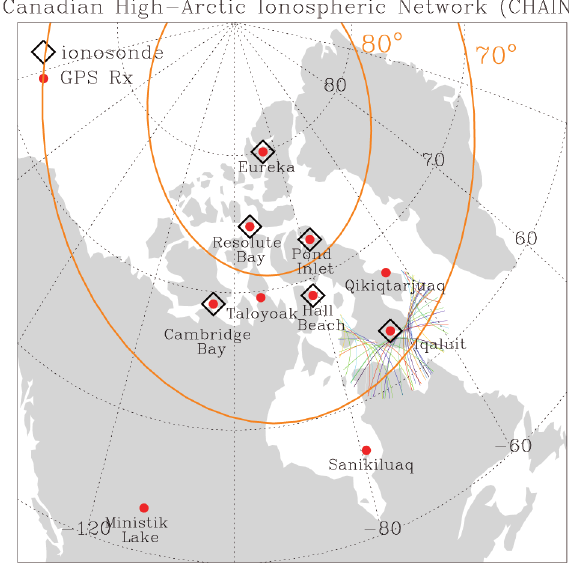
Figure 1. Canadian High Arctic Ionospheric Network (CHAIN). The loci of IPPs at 350 km altitude for all GPS satellites, as seen from Iqaluit at elevation angles above 30° during one day. The CGM latitudes 70° and 80° (yellow) are superposed over the geographic grid in the dotted